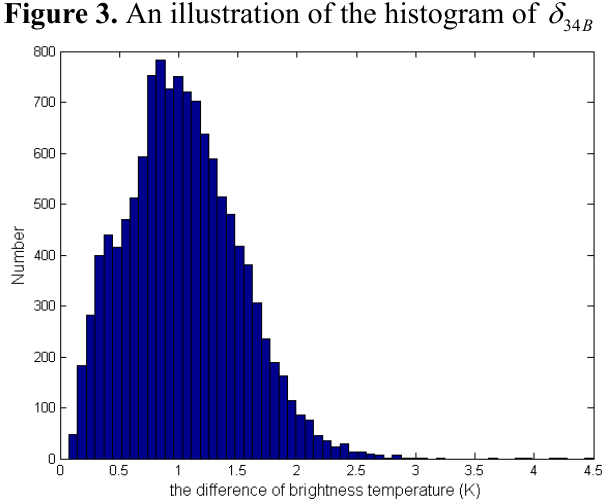
Figure 3. An illustration of the histogram